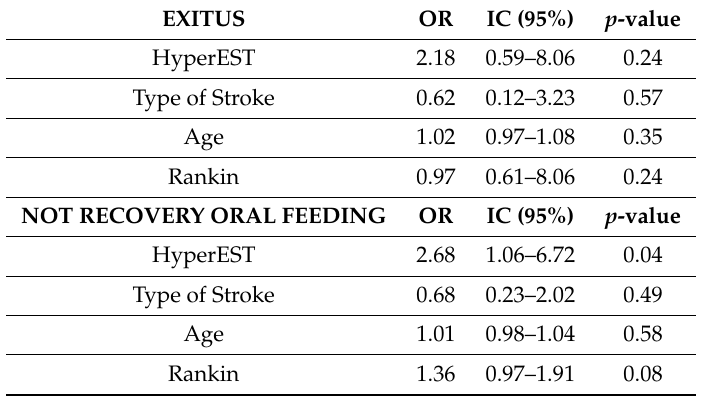
Table 3. Relationship of stress hyperglycaemia (HyperEST) with death according to the type of stroke, age, and